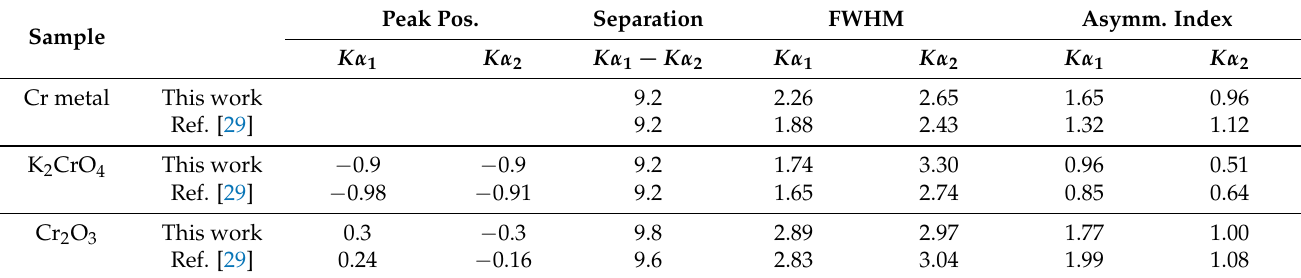
Table 5. Comparison of Cr K α 1,2 peak positions, energy difference between the two peaks (eV), half-width (eV), and asymmetry index of this work and the results of Shuvaev and Kukulyabin [29]. Peak Sample